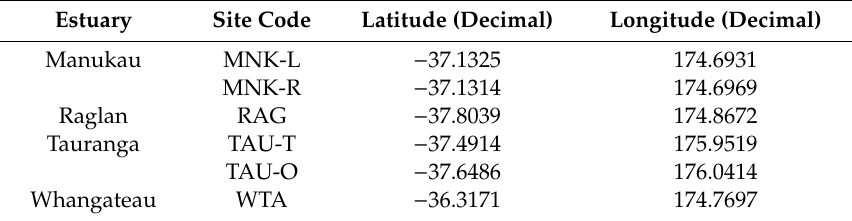
Table A1. Coordinates of site